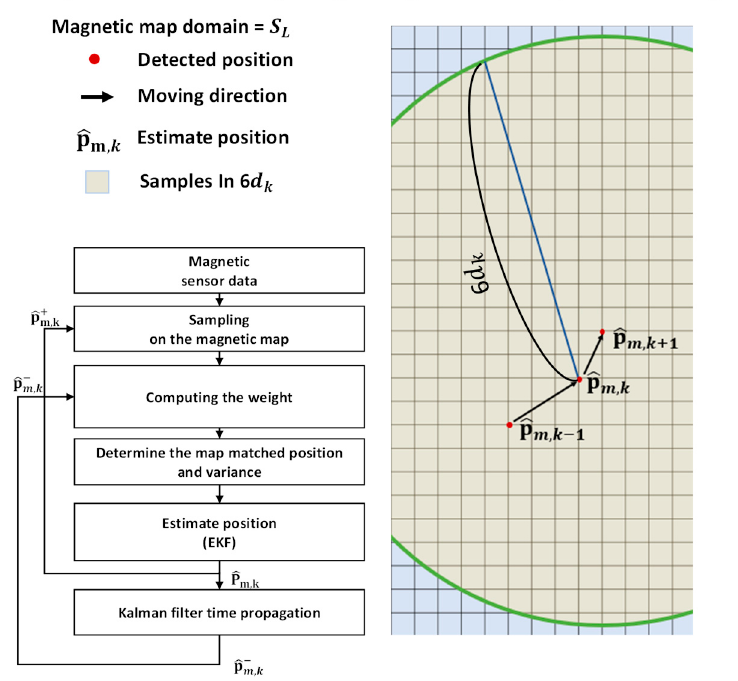
Figure 6. Concept of magnetic map-matching algorithm using importance sampling.